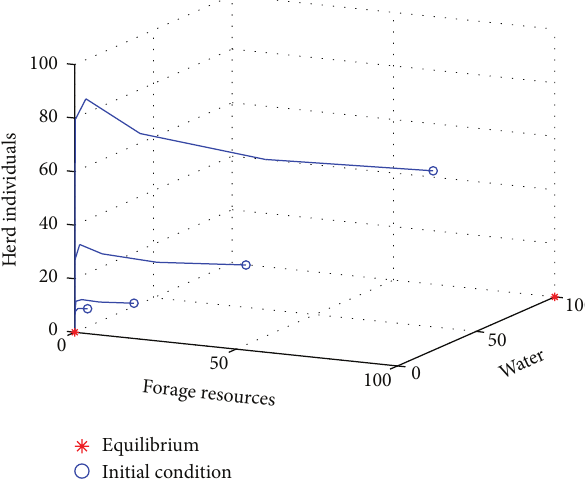
Figure 7: Chronological evolution of the herd’s animals and forage resources of System (1) when 𝑟 = 650 kgDM/ha, 𝑒 = 0.05/ day, 𝑎 = 0.013/ ha, 𝐾 = 800 kgDM/ha, 𝑞 = 0.4/ day,and 𝛾 = 1.0/ day.This illustrates the global stability of the unique coexisting equilibrium = (𝑅 ∗ ,𝐻 ∗ ) . This means that the herd’s animals and forage 𝐸 2 resources have periodic curves since there is a stable limit cycle. The two populations can exist together.